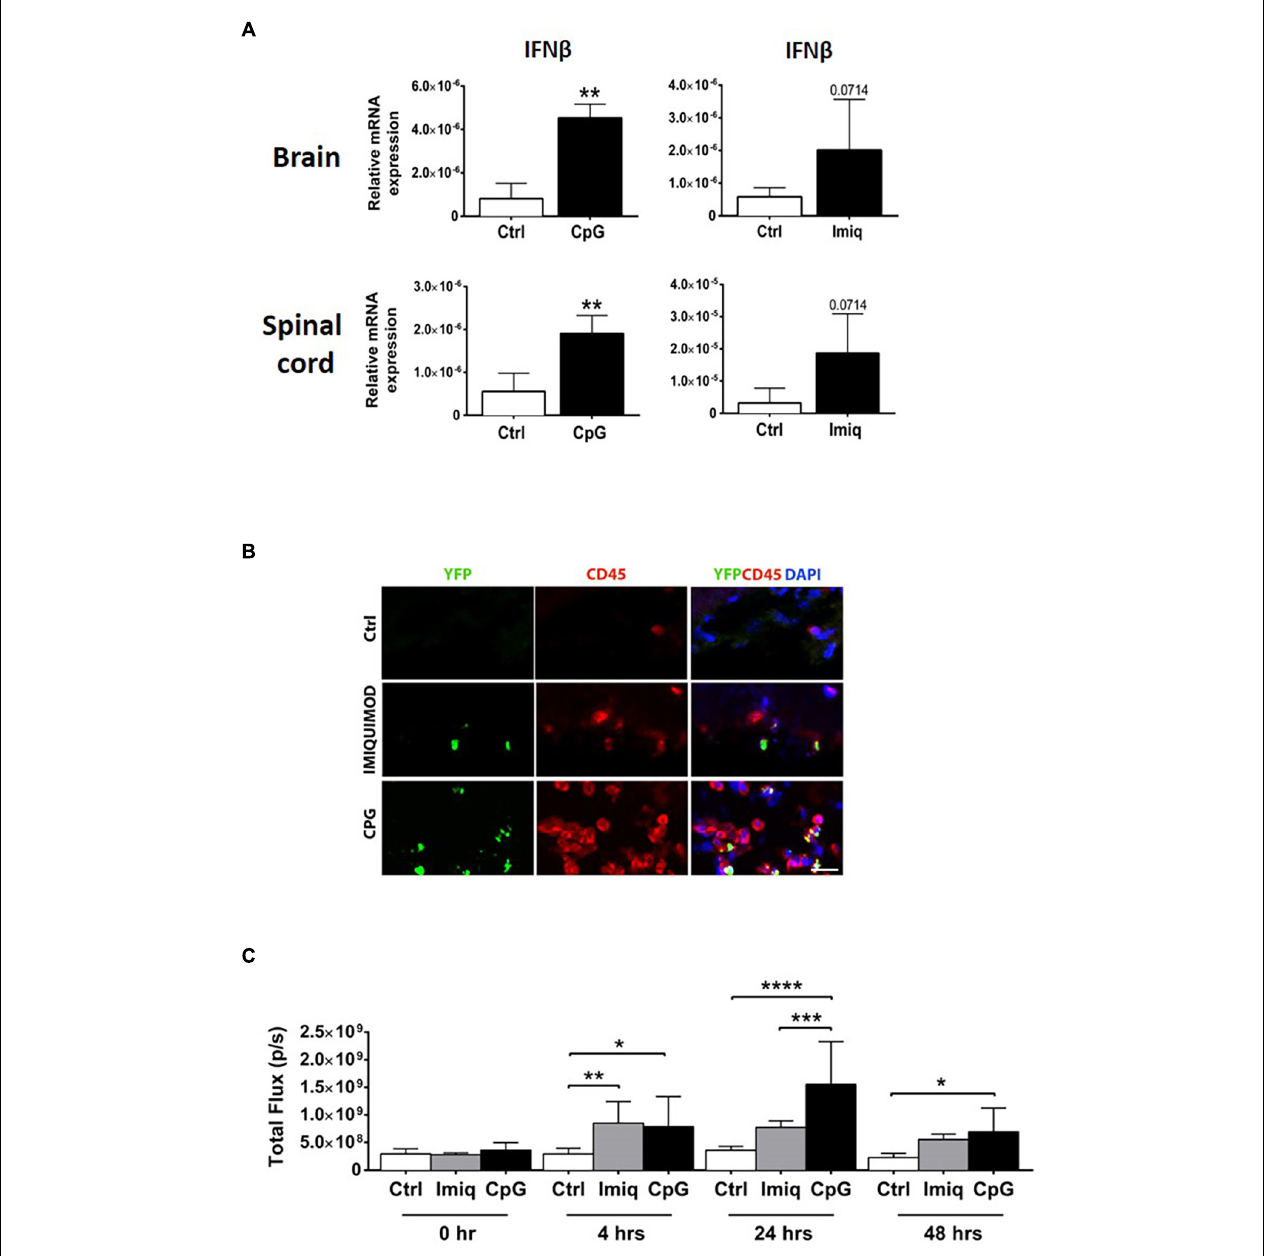
FIGURE 2 | Intrathecal CpG induced higher levels of IFN β in the CNS in comparison to Imiquimod. Brains and spinal cords were analyzed 4 h post intrathecal injection of CpG and Imiquimod (Imiq) into healthy mice. (A) Bar graphs show mRNA levels of IFN β ( n = 3–6 per group). Results were analyzed using the two-tailed Mann–Whitney U -test. (B) Representative micrographs of brain sections from control mice and mice that received intrathecal Imiquimod or CpG 4 h earlier. Co-localization of IFN β /YFP+ (green) and CD45+ (red) cells in mice is shown. Nuclei were stained with DAPI (blue). Scale bar: 20 µ M. (C) IFN β /luciferase reporter mice received either intrathecal CpG or Imiquimod and in vivo imaging measured the level of IFN β /luciferase at 0, 4, 24, and 48 h post injection ( n = 4–7 per group). Results were analyzed using one-way ANOVA with multiple comparisons uncorrected Fisher’s LSD test. Data are presented as means ± SD. * p < 0.05; ** p < 0.01; *** p < 0.001; **** p <